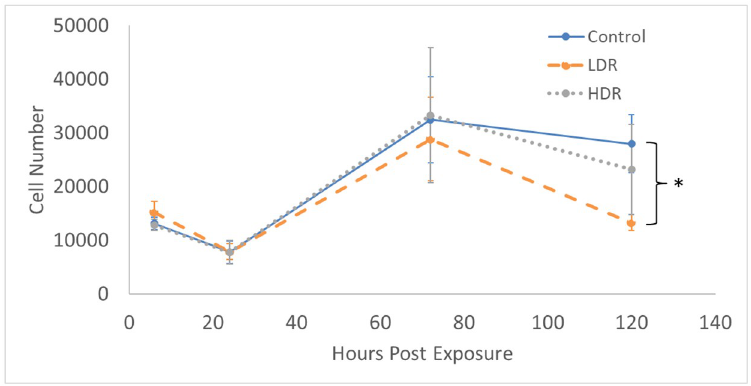
Fig 1. Total cell number present in culture after 2Gy gamma irradiation. N = 3 independent experiment for each time point and � indicates that the point is statistically different (p < 0.05) from the control at the same day. https://doi.org/10.1371/journal.pone.0250160.g001 membrane potential corresponds to a later stage of apoptosis. As seen in Fig 4, the proportion of healthy cells grew over time, but HDR samples 12 hours after exposure were significantly different from control and LDR samples. Both LDR and HDR samples were significantly dif- ferent from control on day 2 for early apoptotic cells, though the proportion of early apoptotic